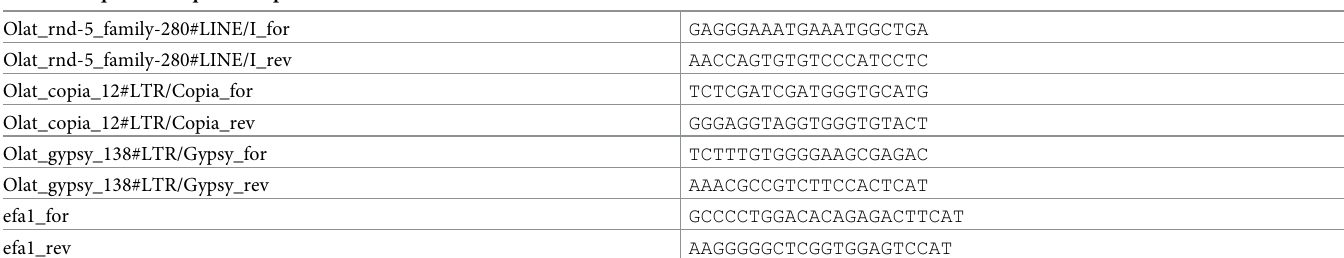
Table 1. Sequences of qRT-PCR primers.